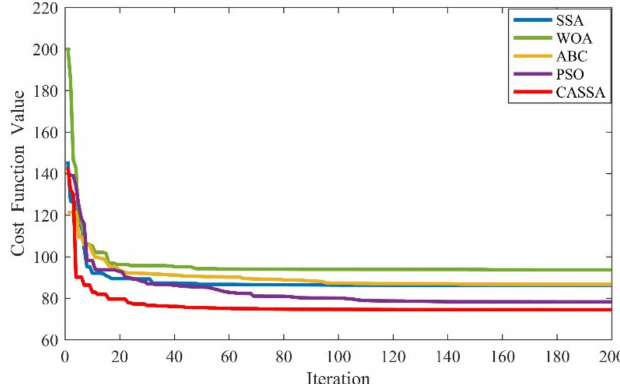
Figure 11. The best results of CASSA, ABC, PSO, SSA, and